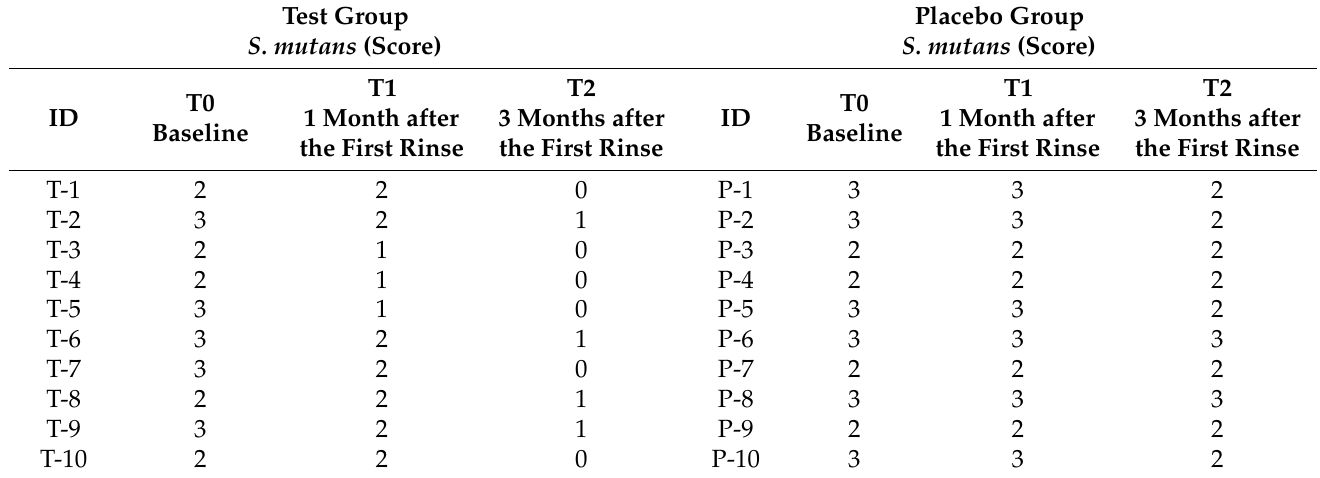
Table 3. Different values of S. mutans score between the Study Group and the Placebo Group. Test Group